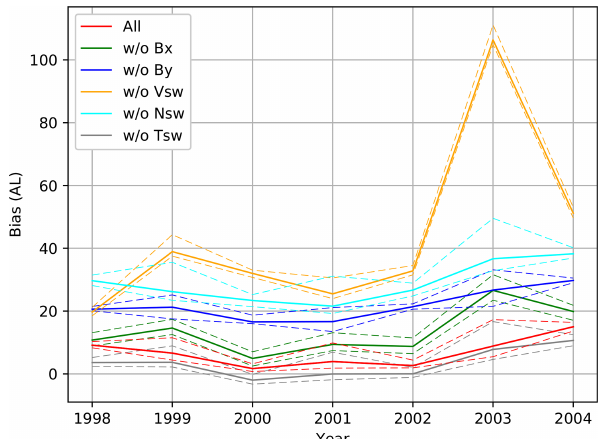
Figure 4. Mean deviation in each year for the various synthetic AL indices with the effect of one of the solar-wind parameters